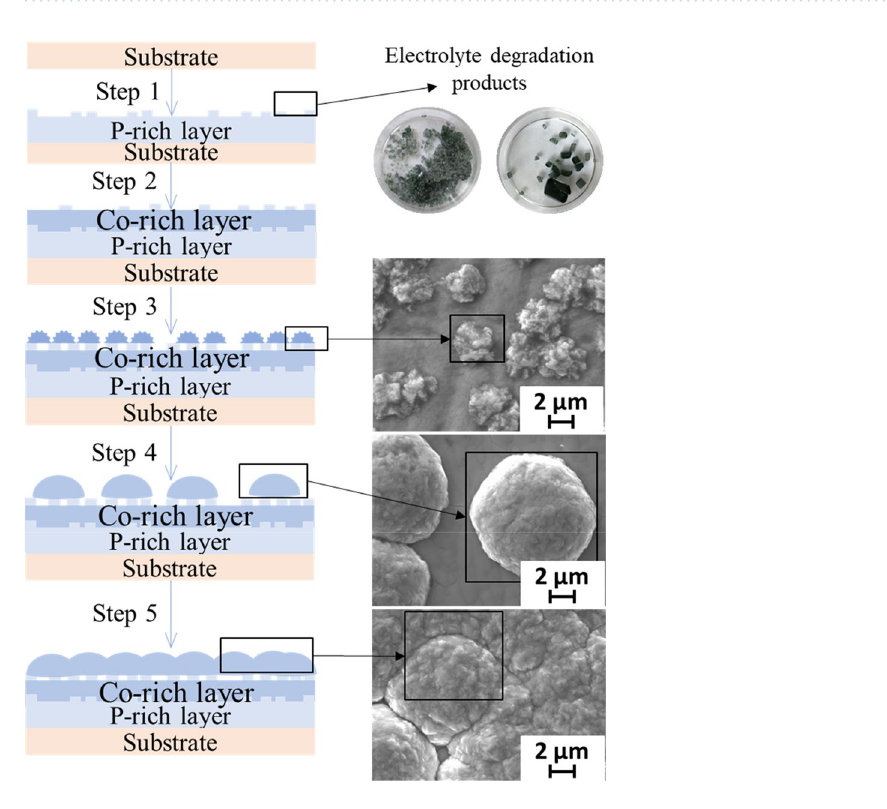
Figure 5. A schematic view of the CoNiP coating growth